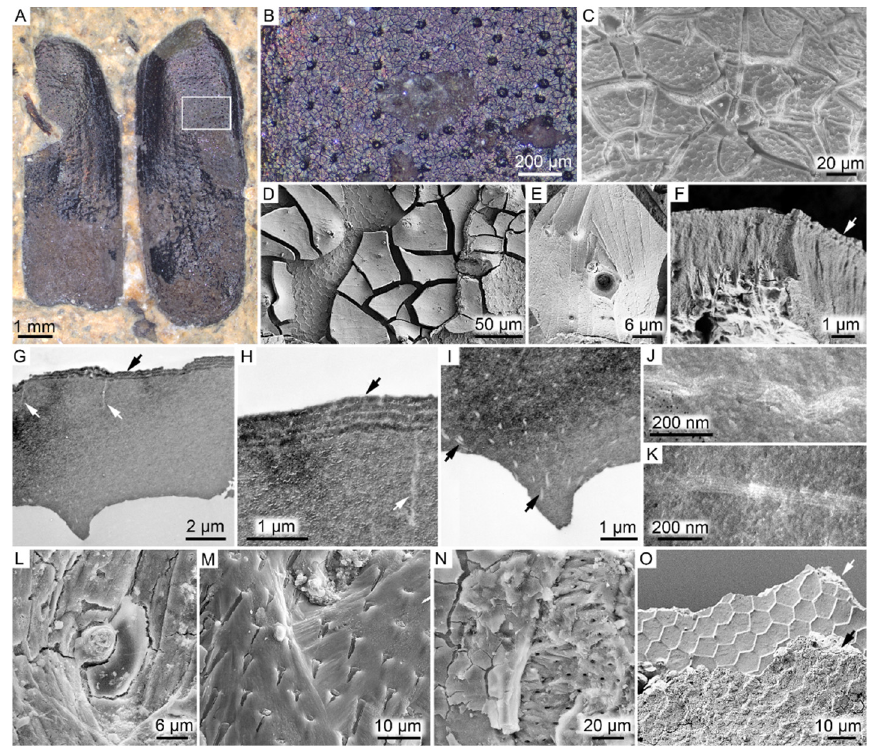
Figure 1. FUM-N-17627 (Coleoptera). ( A ) The fossil elytra in dorsal view prior to sampling, display- ing a faint metallic shine under conventional light. ( B ) Higher magnification of the dark matter from the area demarcated in ( A ). ( C ) SEM micrograph of the external (outer) surface of the elytra. Note hexagonal patterning and desiccation cracks. ( D , E ) SEM micrographs of the smooth internal surface of the elytra. Note hexagonally arranged imprints in the sedimentary matrix neighboring the fossil matter. ( F ) SEM micrograph showing a section through the predominantly amorphous cuticular matrix. Note thin layers along the external margin of the elytra (indicated by an arrow). ( G ) TEM micrograph depicting a vertical section through the elytra. Note largely amorphous interior save for thin subvertical rifts (white arrows) and four electron-dense layers that alternate with thinner, electron-translucent bands (black arrow). ( H ) Higher magnification of the thin structures (white